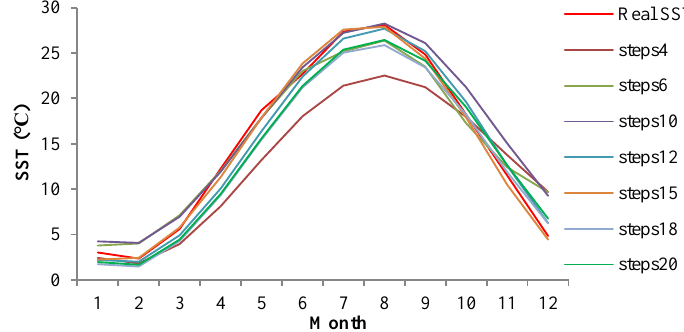
Figure 7. SST prediction for 12 months under different steps.